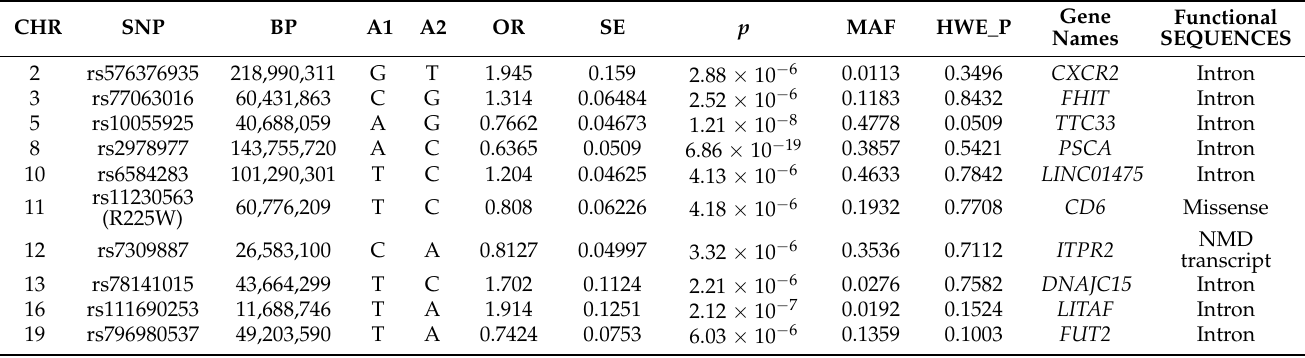
Figure 2. Distribution of genetic variants associated with duodenal ulcers based on the genome-wide association study. ( A ) Manhattan plot of the p -value of genetic variants for duodenal ulcer risk. ( B ) Quantile – quantile (Q – Q) plot of observed and expected p -values for duodenal ulcer risk. Table 3. Characteristics of ten genetic variants selected for their interactions by